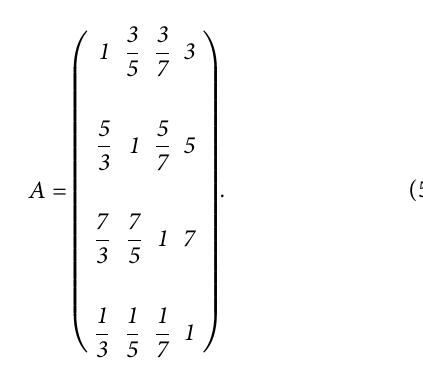
Figure 10: The effect of mineral powder content: (a) average ultimate tensile strength, (b) average tensile elongation rate, and test age. The matrix is 3 × 4 matrix, in which each column of the matrix represents the order of scheme level C corresponding to criterion level B , as